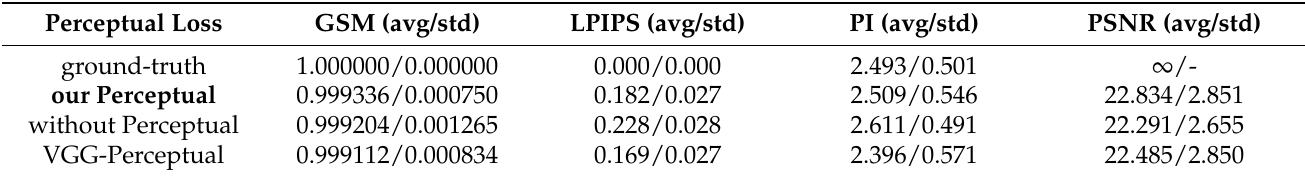
Table 2. The comparison of varied perceptual loss.